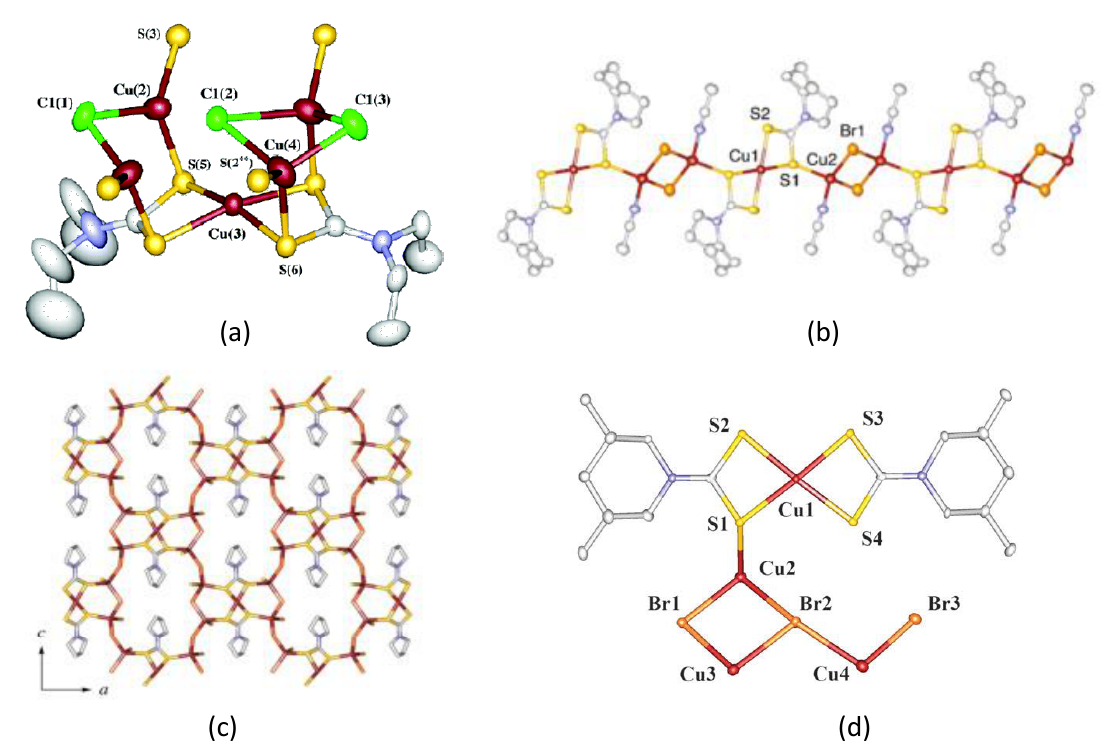
Figure 18. Representations of the molecular structures of ( a ) the cation in [Cu 5 (S 2 CNEt 2 ) 2 Cl 3 ][FeCl 4 ], ( b ) the 1D coordination polymer [Cu{S 2 CN(CH 2 ) 6 } 2 .Cu 2 Br 4 ], ( c ) the 3D structure of coordination polymer [Cu{S 2 CN(CH 2 ) 4 } 2 .Cu 2 Br 4 ] and ( d ) the molecular sub-unit on [Cu{S 2 CN(CH 2 ) 3 (CHMe) 2 } 2 · Cu 3 Br 3 ]. ( a , b ) Reproduced with permission from [133,136]. Copyright 2005 and 2010 American Chemical Society. ( c , d ) Reproduced with permission from [134,138] Copyright 2011 and 2013 The Royal Society of Chemistry.